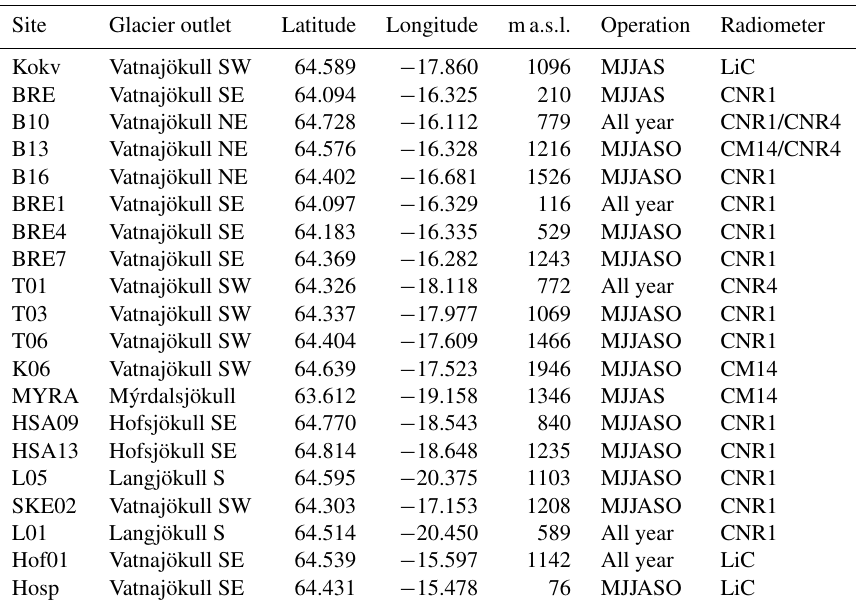
Table 1. Overview of average location, elevation, average operating period, and radiometer instrument of the GAWS network used for vali- dation. All stations have temperature probes while GV (Grímsvötn) and GF (Grímsfjall) only observe temperature and incoming shortwave irradiation. Location and elevation are based on the average location of the site for the observation period, i.e. mean location values for multi-year installations which might not be the exact same location from one year to another. Site Glacier outlet Latitude Longitude